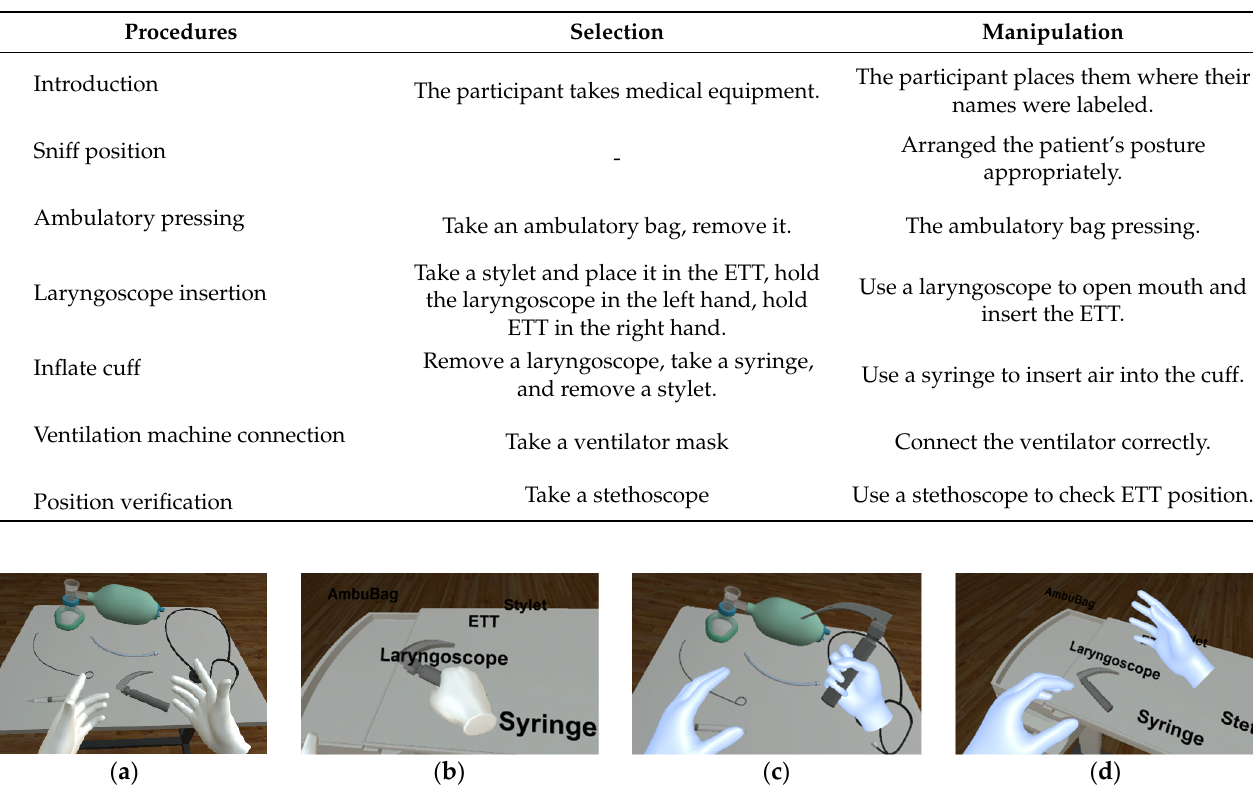
Figure 4. The scene of sniff position and ambulatory bag pressing: ( a ) text assistance; ( b ) pressing with controller; ( c ) sniff position with hand; ( d ) pressing with hand. ( a ) ( d ) Figure 5. The scene of laryngoscope insertion and inflate cuff: ( a ) laryngoscope insertion with controller; ( b ) remove laryn- goscope; ( c ) laryngoscope insertion with hand; ( d ) inflate cuff with hand. ( a ) ( d ) Figure 6. The scene of ventilation machine connection and verification: ( a ) connection with controller; ( b ) verification with controller; ( c ) connection with hand; ( d ) verification with hand.